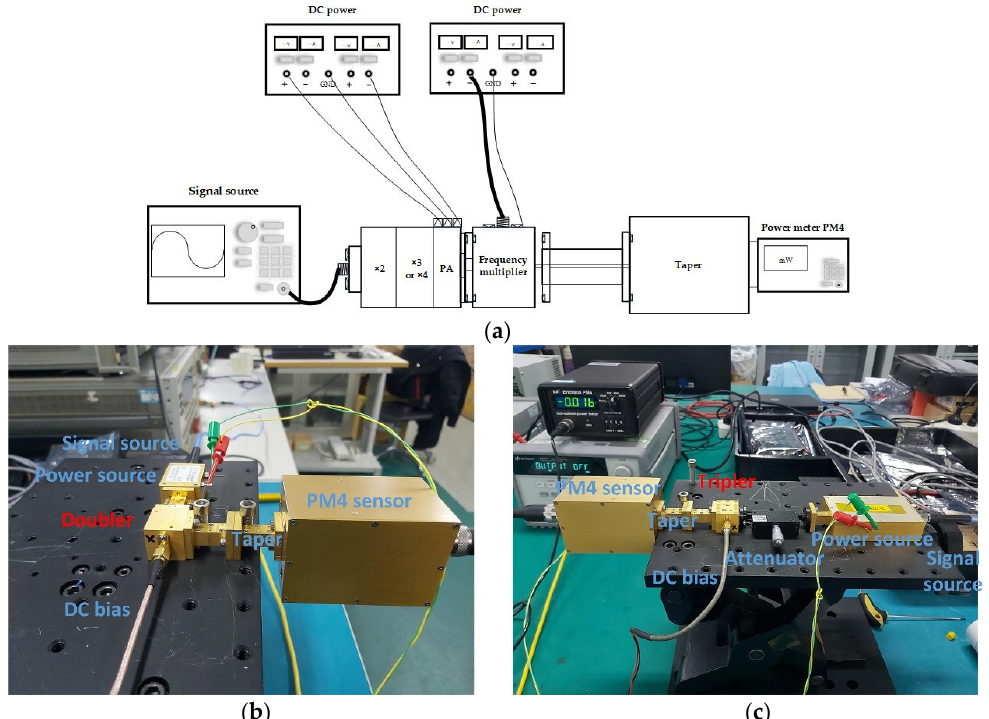
Figure 6. ( a ) Test bench and measurement diagram of the frequency multipliers; ( b ) Photo of test site for the the 200 GHz doubler; ( c ) Photo of test site for the 215 GHz tripler.